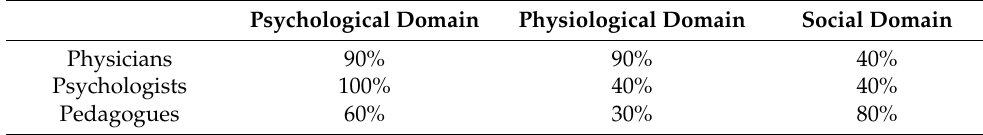
Table 3. Estimated applicability of therapeutic climbing by expert